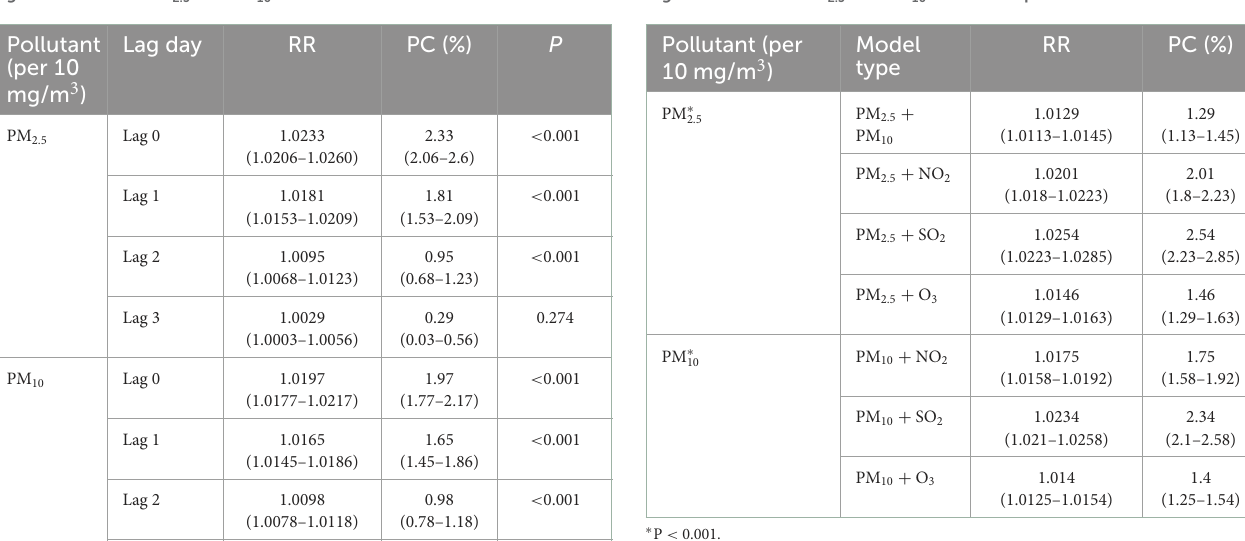
TABLE 4 The RR and percent change of eczema risk associated with 10 mg/m 3 increase of PM 2.5 and PM 10 .